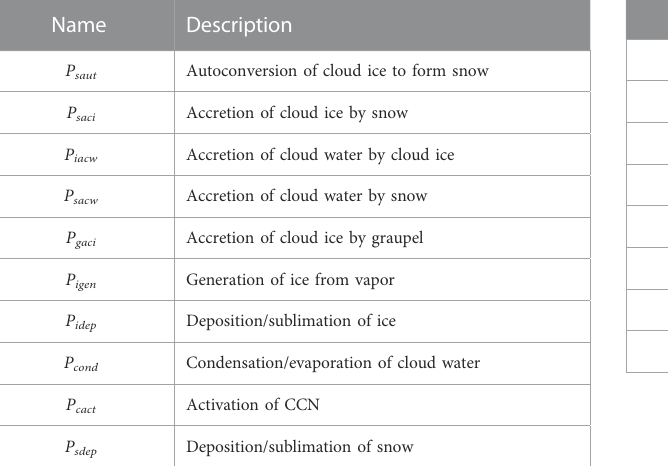
TABLE A2 Description of the mainmicrophysical processesin HUJI